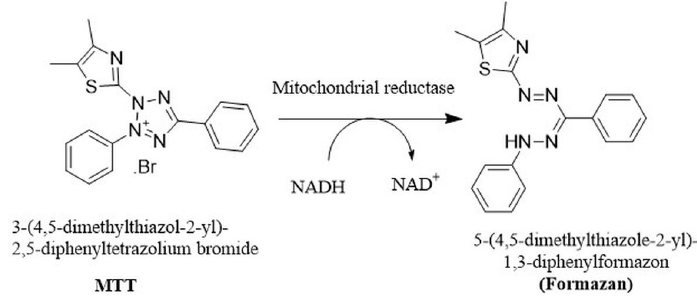
Scheme 3. Conversion of MTT into formazan crystals by mitochondrial reductase